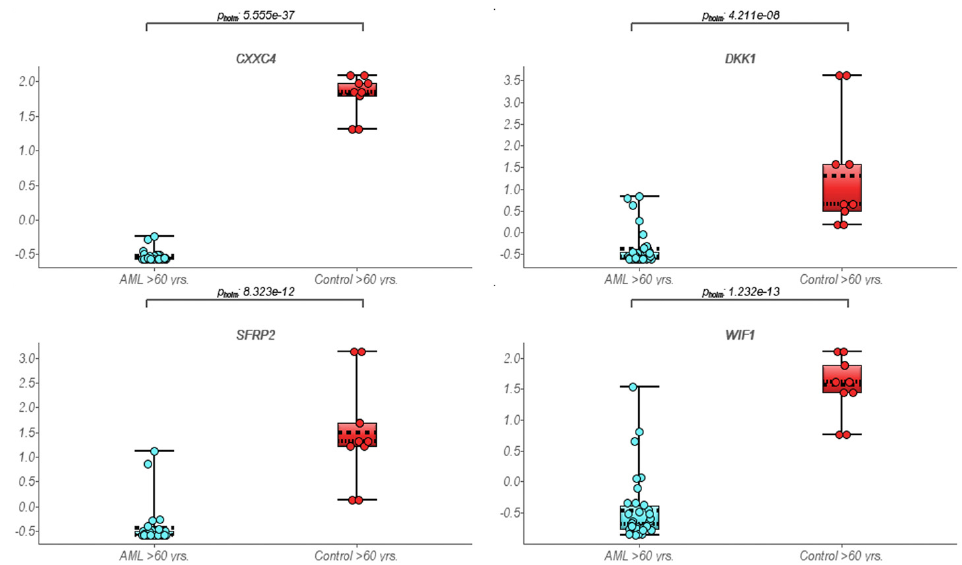
Figure 2. Box plot representing suppressed expression of selective Wnt / β‐ catenin inhibitor genes among elderly AML samples compared to normal controls.